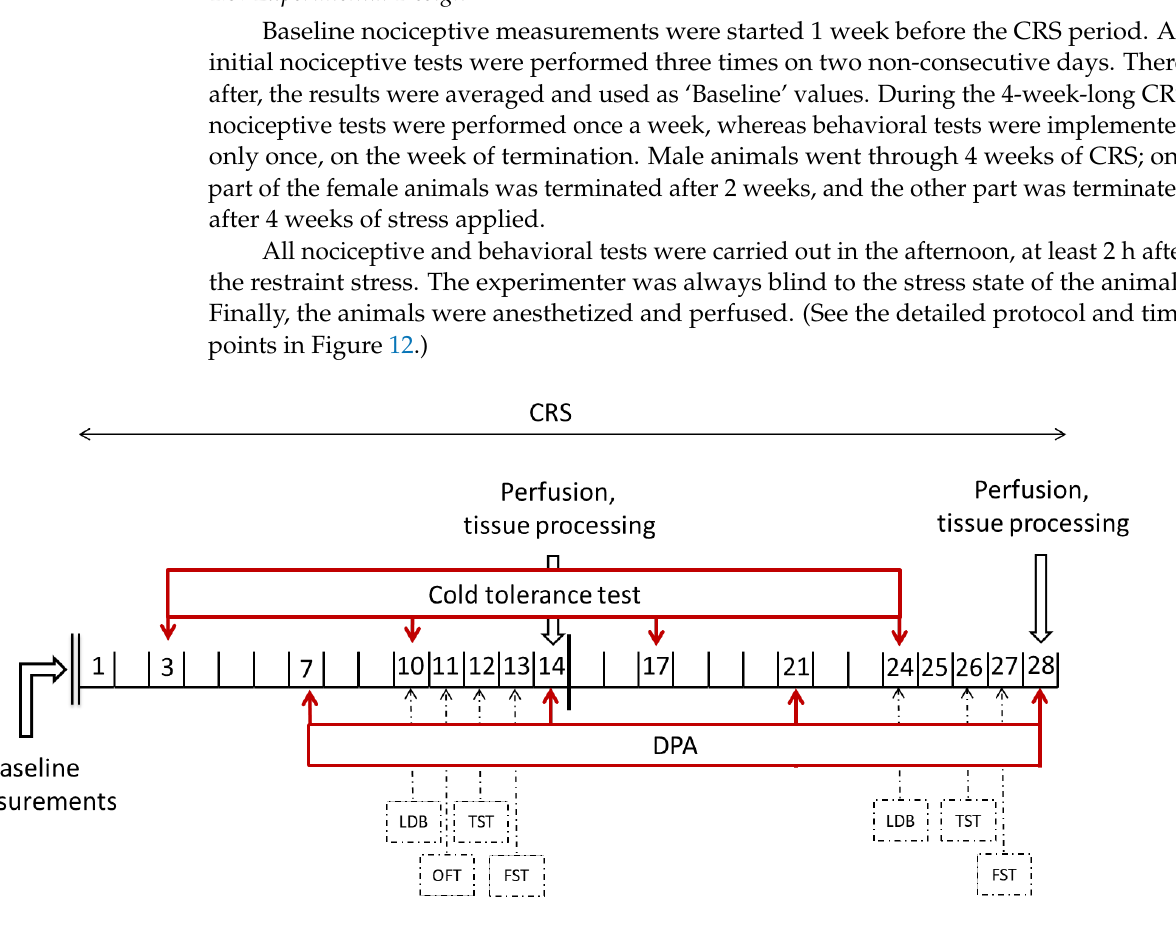
Figure 12. Experimental design including the timing of the baseline measurements, chronic restraint stress (CRS), nociceptive and behavioral tests and perfusion. DPA: dynamic plantar esthesiometry; LDB: light–dark box test; OFT: open field test; TST: tail suspension test; FST: forced swim test.